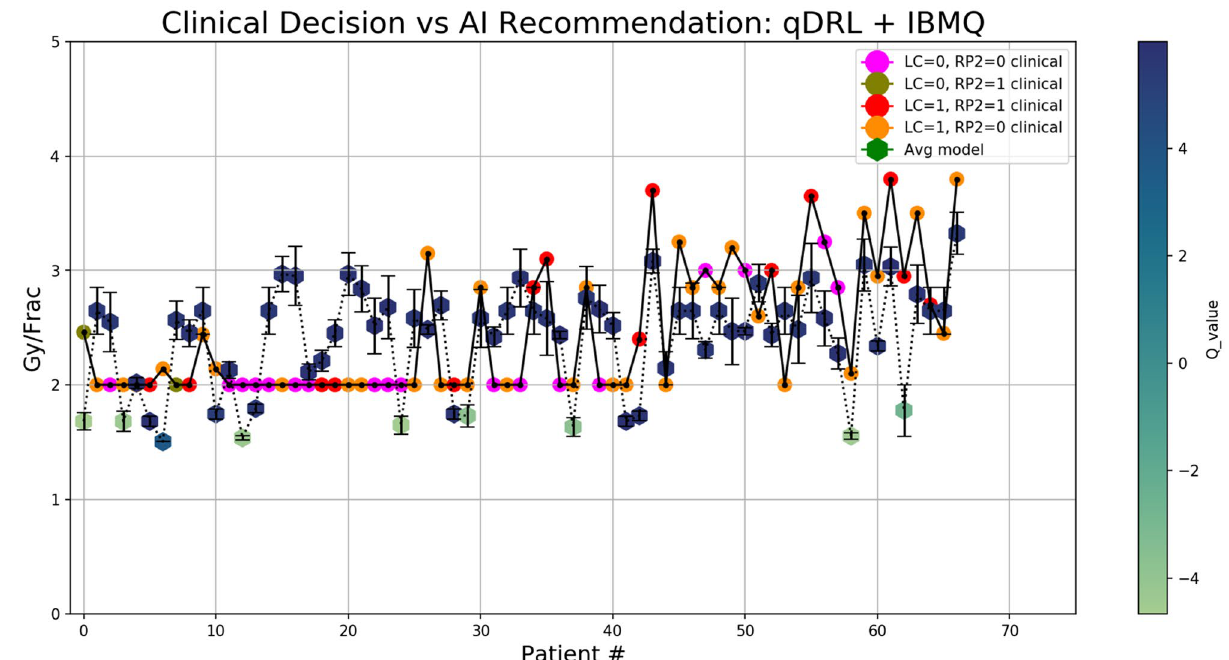
Figure 3. Clinical decision support system dose adaptation recommendation. Comparison between retrospective clinical decision and AI recommendations obtained from the quantum deep reinforcement learning (qDRL) model trained in the IBMQ quantum processor. Each datapoint corresponds to the dose decision (dose per fraction) for the last one-third treatment period for the training dataset. The clinical data points are color-coded according to the four possible binary clinical outcomes: LC = 0 (no local control) and RP2 = 0 (no radiation induced pneumonitis of grade 2 or higher), LC = 0 and RP2 = 1, LC = 1 and RP2 = 1, and LC = 1 and RP2 = 0. Here LC = 1 and RP2 = 0 is the clinical desirable outcome. The AI recommendation is color- coded according to the q-value (expected return of recommending a dose), which can be loosely interpreted as the AI’s confidence in its recommendation. Here, the AI recommendations are averages of 5 identically trained models with standard error of mean as uncertainty. For clarity, this figure is rotated and presented in landscape format in the Supplementary